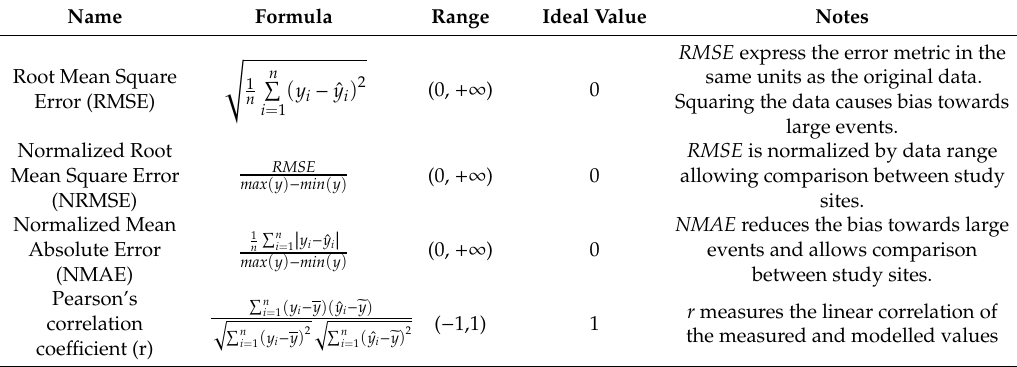
Table 3. Metrics for assessing model performance, where n is the number of observations of y, y i is the ith observation, y is the mean of observations, ˆ y is the modelled value and (cid:101) y is the mean of modelled values